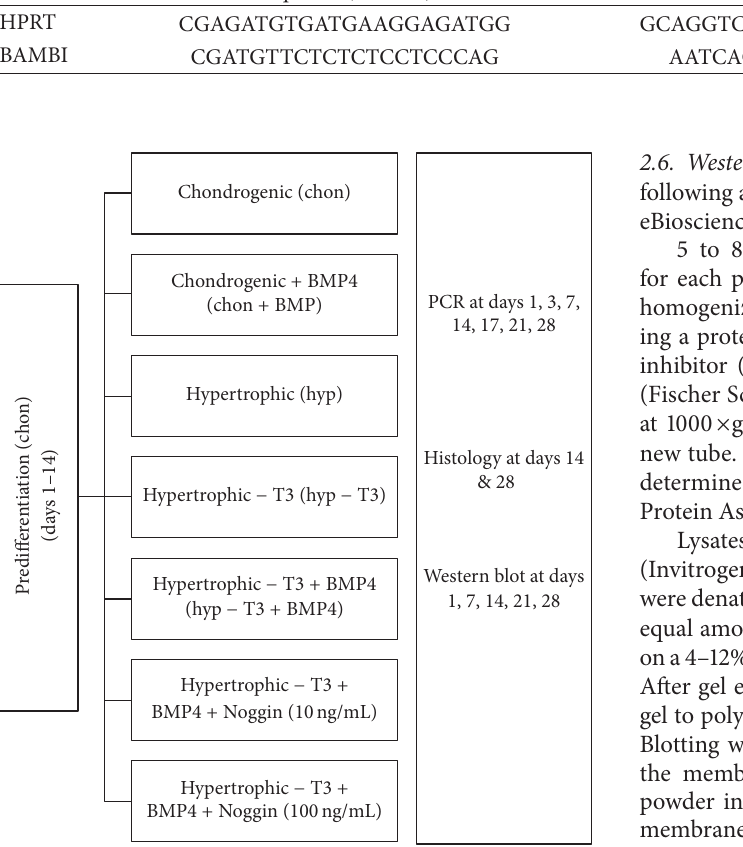
Figure 1: Schematic of groups and treatments: left bar shows chondrogenic predifferentiation in TGF- 𝛽 containing medium from days1–14.Midlinebarsshowtreatmentofgroupsafterchondrogenic predifferentiation from day 14 to day 28. Right column shows outcome measurements in regard of time points. Overall culture duration after expansion was 28